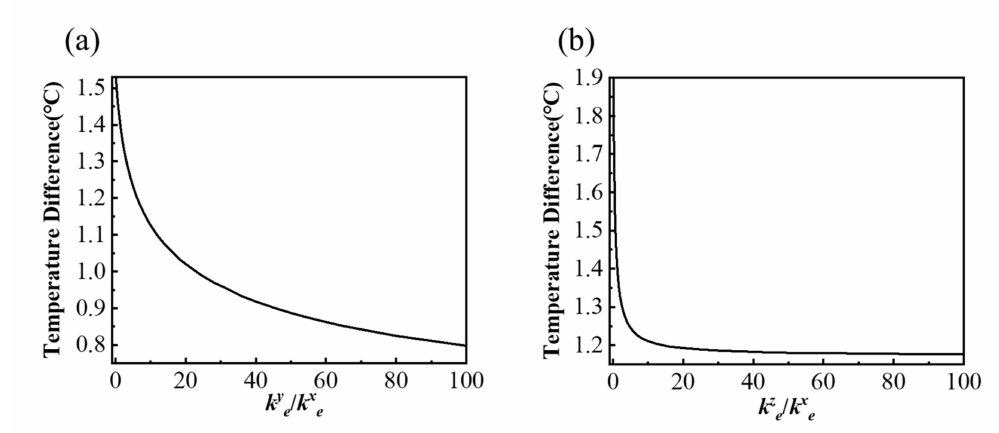
Figure 7. Effects of the orthotropic encapsulation with different ratios of ( a ) k ey / k ex and ( b ) k ez / k ex on the thermal uniformity of the bottom surface of the